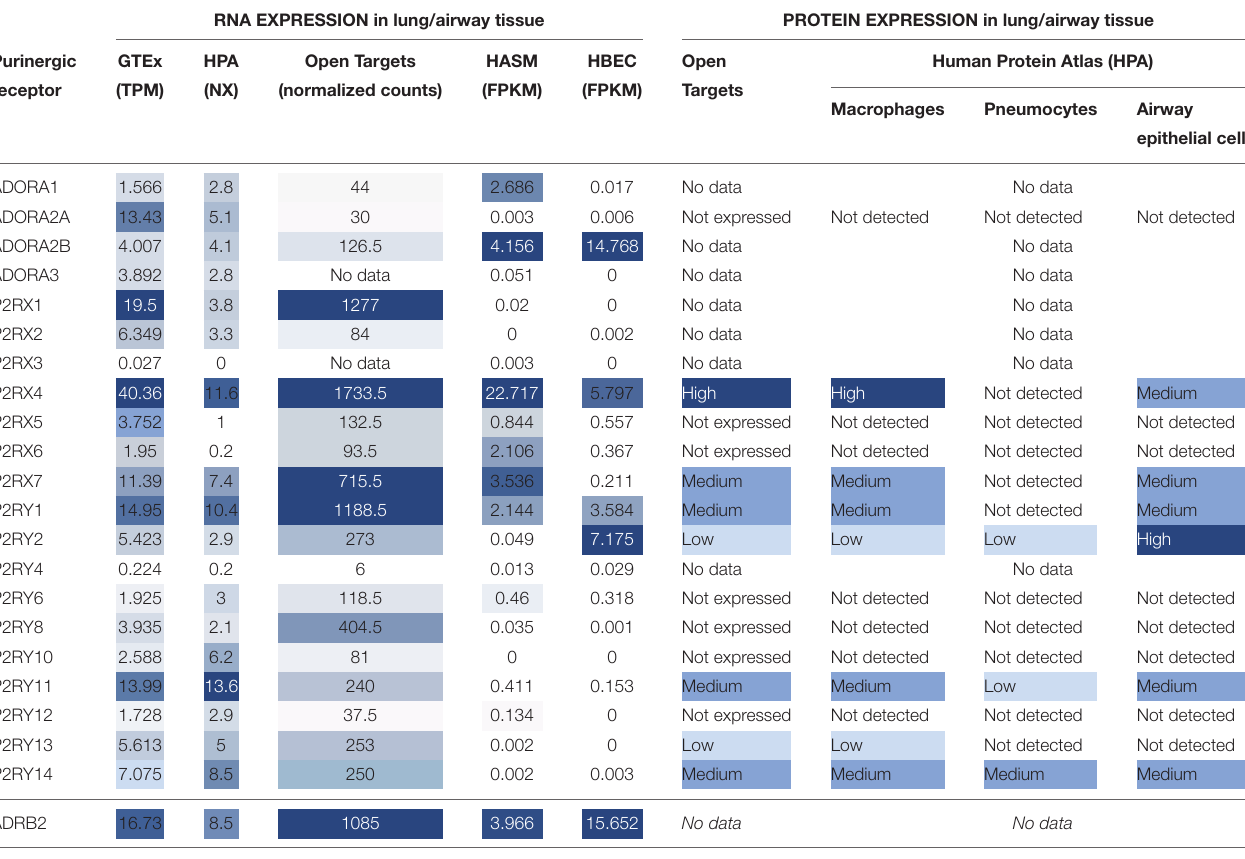
TABLE 2 | Purinergic receptor RNA and protein expression in lung and airway tissue from multiple online bioinformatics resources and novel RNA-Seq data. RNA EXPRESSION in lung/airway